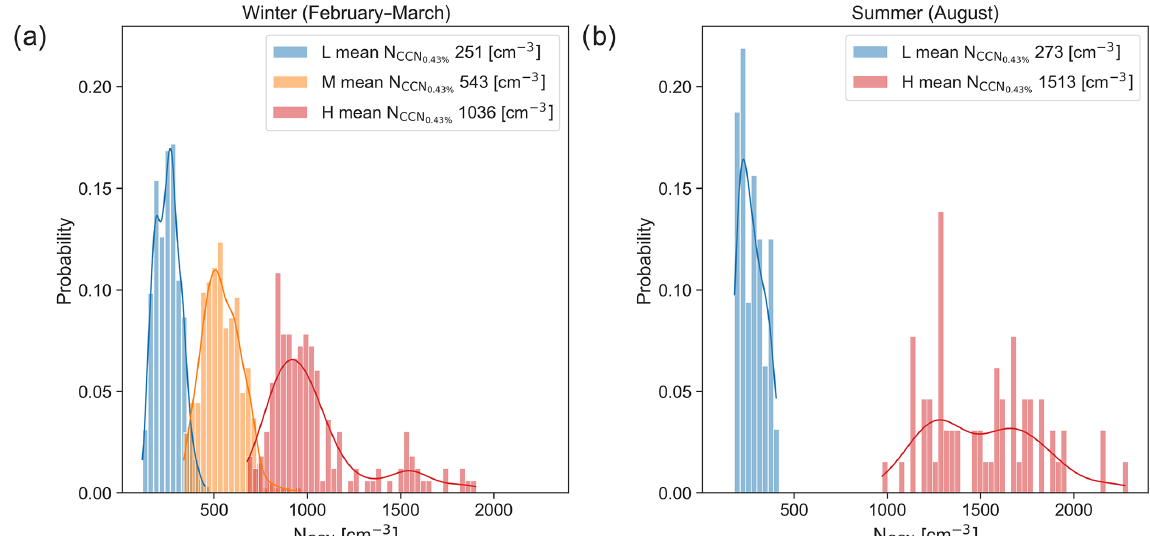
group with their mean 0 . 43%